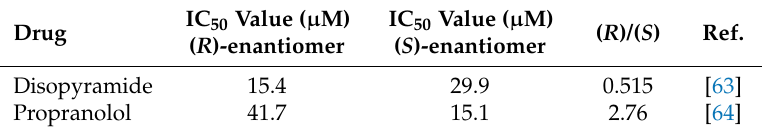
Table 2. IC 50 values of each enantiomer of disopyramide and propranolol for OCT1.